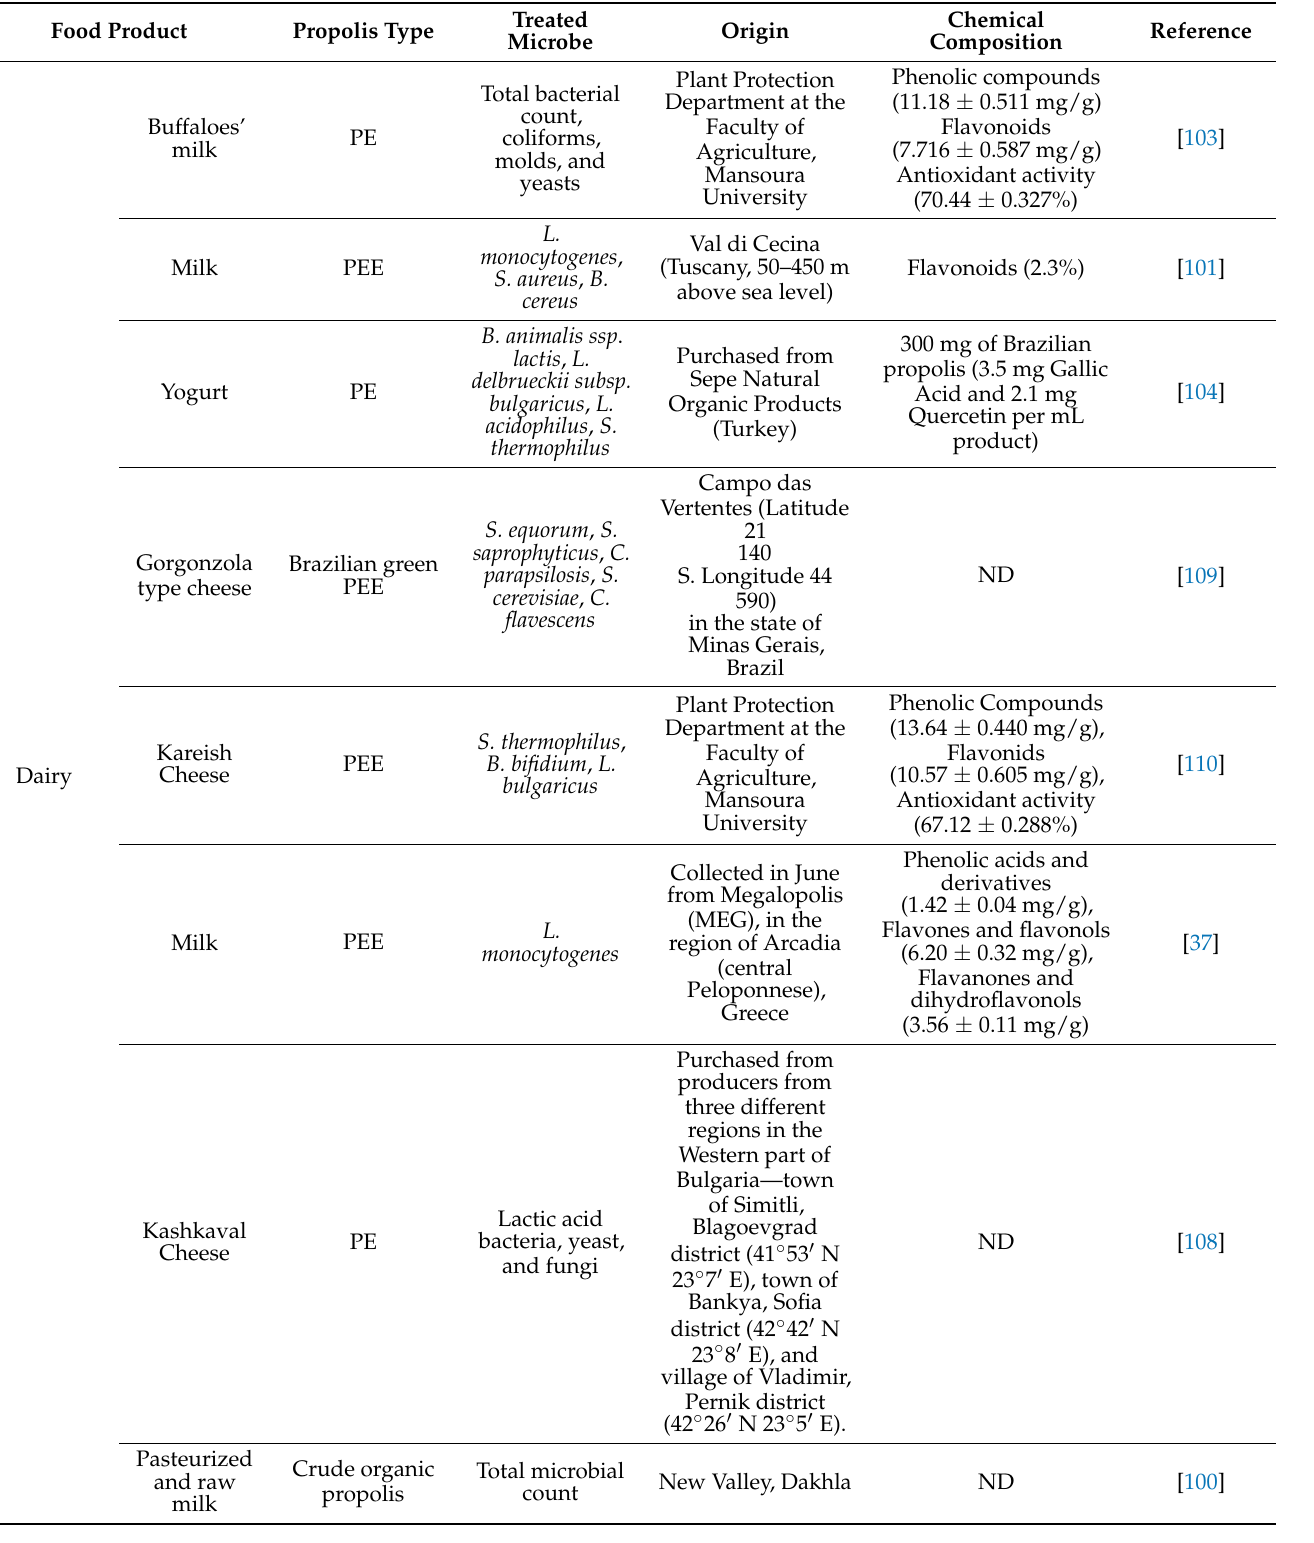
Table 2. Impact of propolis on different food